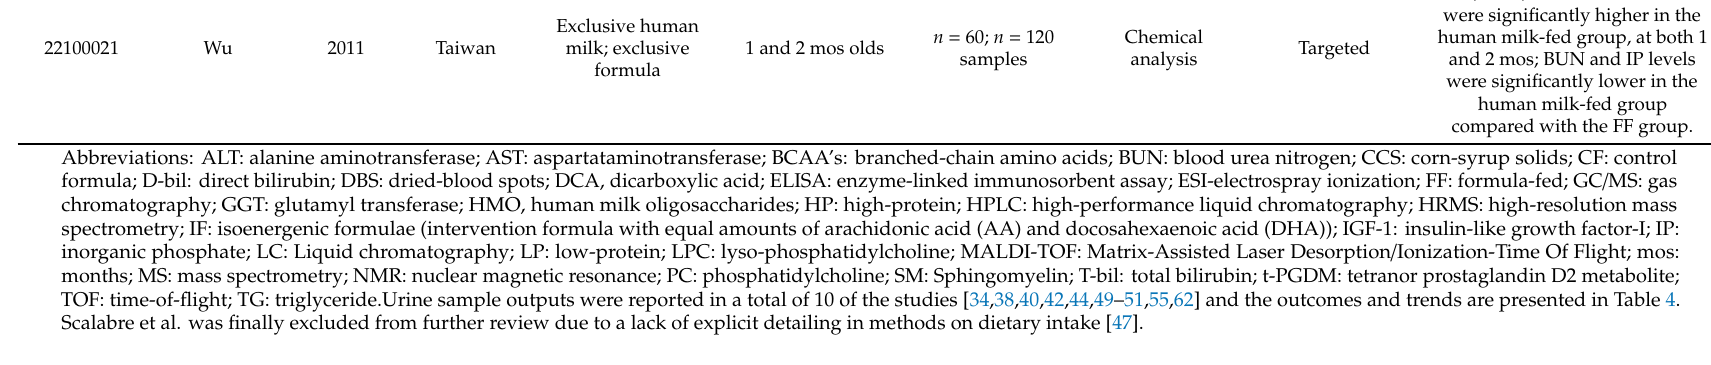
Table 3. Manuscripts reporting urine metabolites from human milk- and / or formula-fed infants ( n =